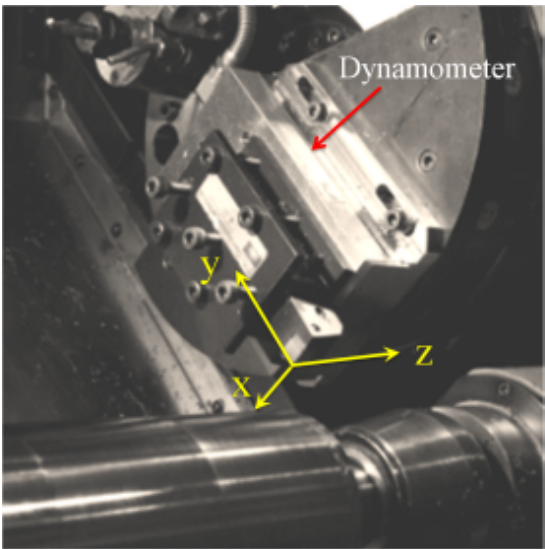
Figure 1: Experimental setup. turning workspace with dynamometer.